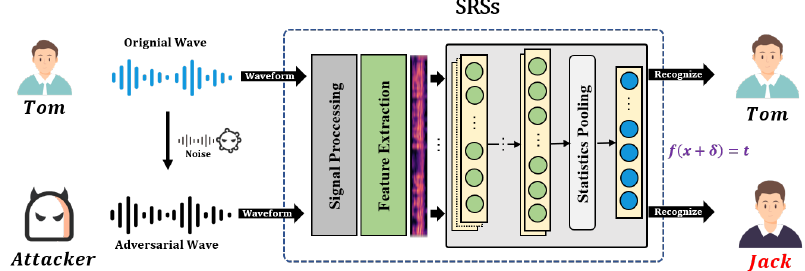
Figure 2. General framework of adversarial attacks against